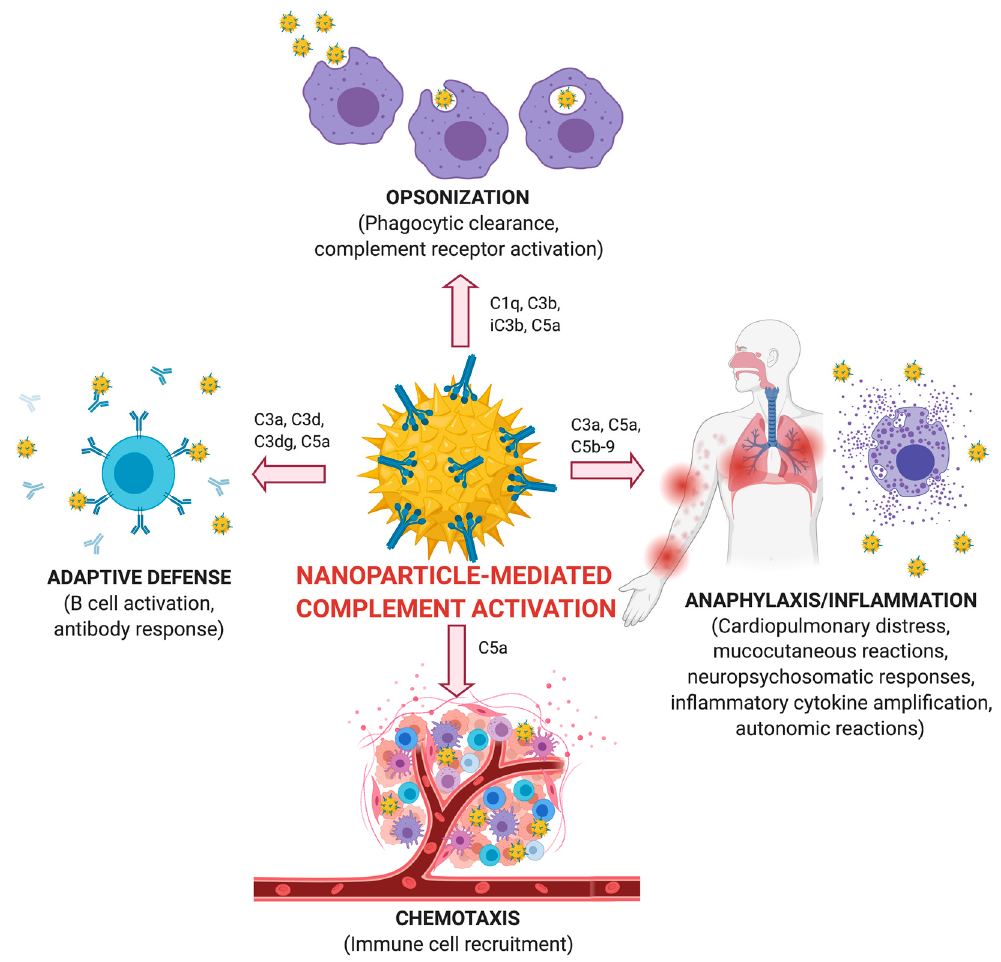
Figure 3. Key complement activation products in opsonization, anaphylaxis/inflammation, chemotaxis and adaptive defense resulting from nanoparticle-mediated complement activation. Created using BioRender.com.